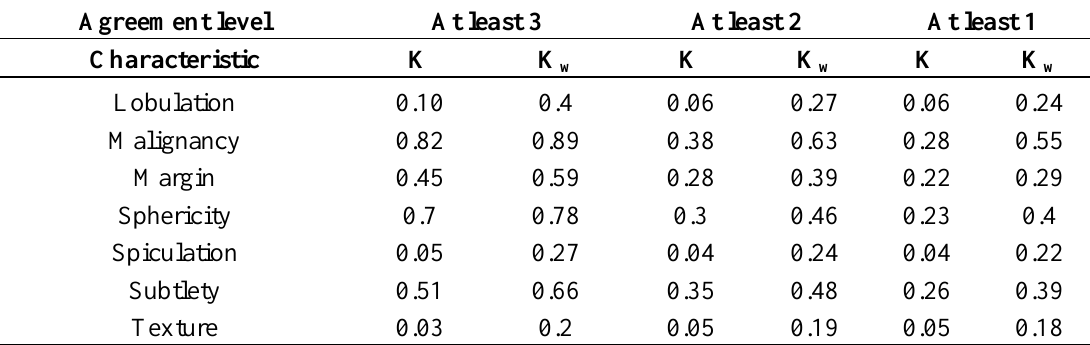
Table 12. Kappa statistics of different agreement level subsets of a new LIDC dataset. Agreement